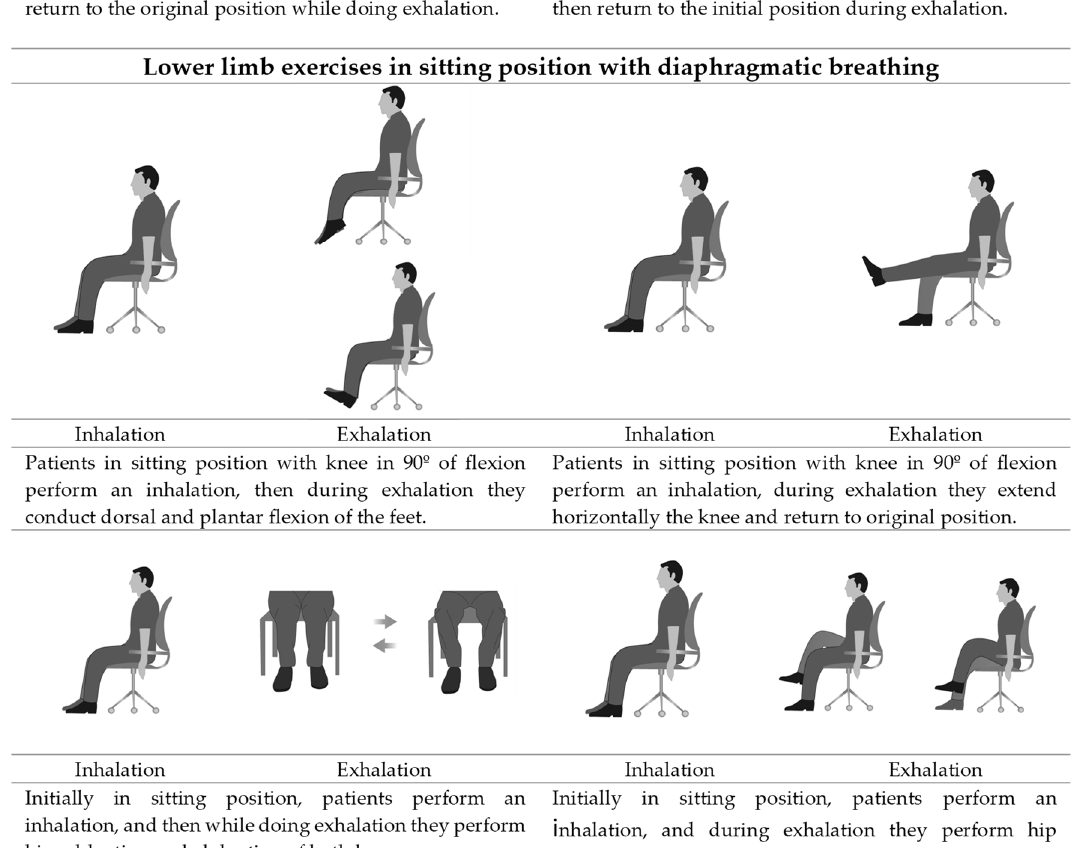
Figure 1. Diaphragmatic breathing combined with musculoskeletal exercises.